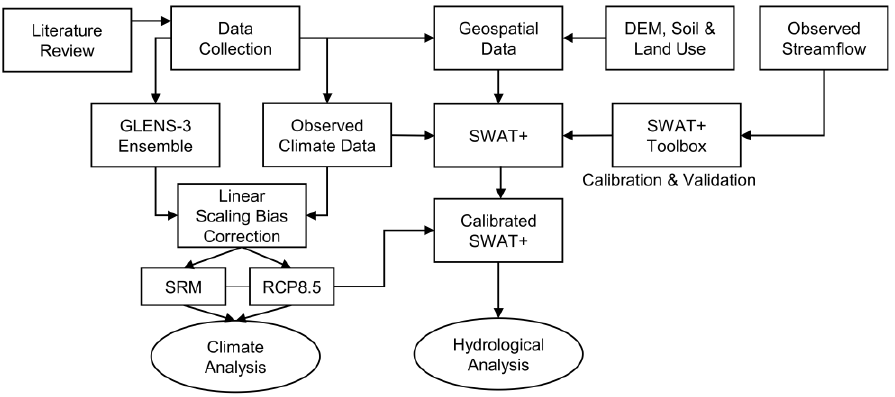
Figure 2. The conceptual framework of SRM hydro-climatic impact assessment using SWAT+.